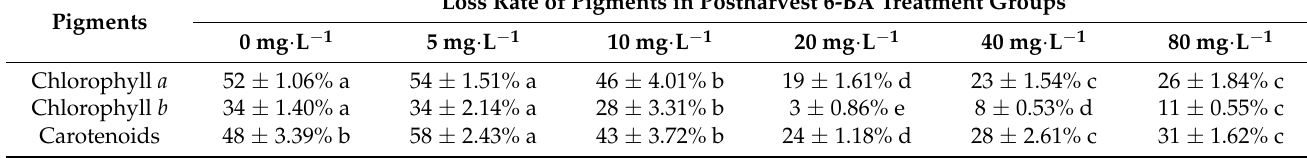
Table 2. Loss rate of pigment substances at day 6 of storage in Chinese flowering cabbage treated with different concentrations of 6-BA